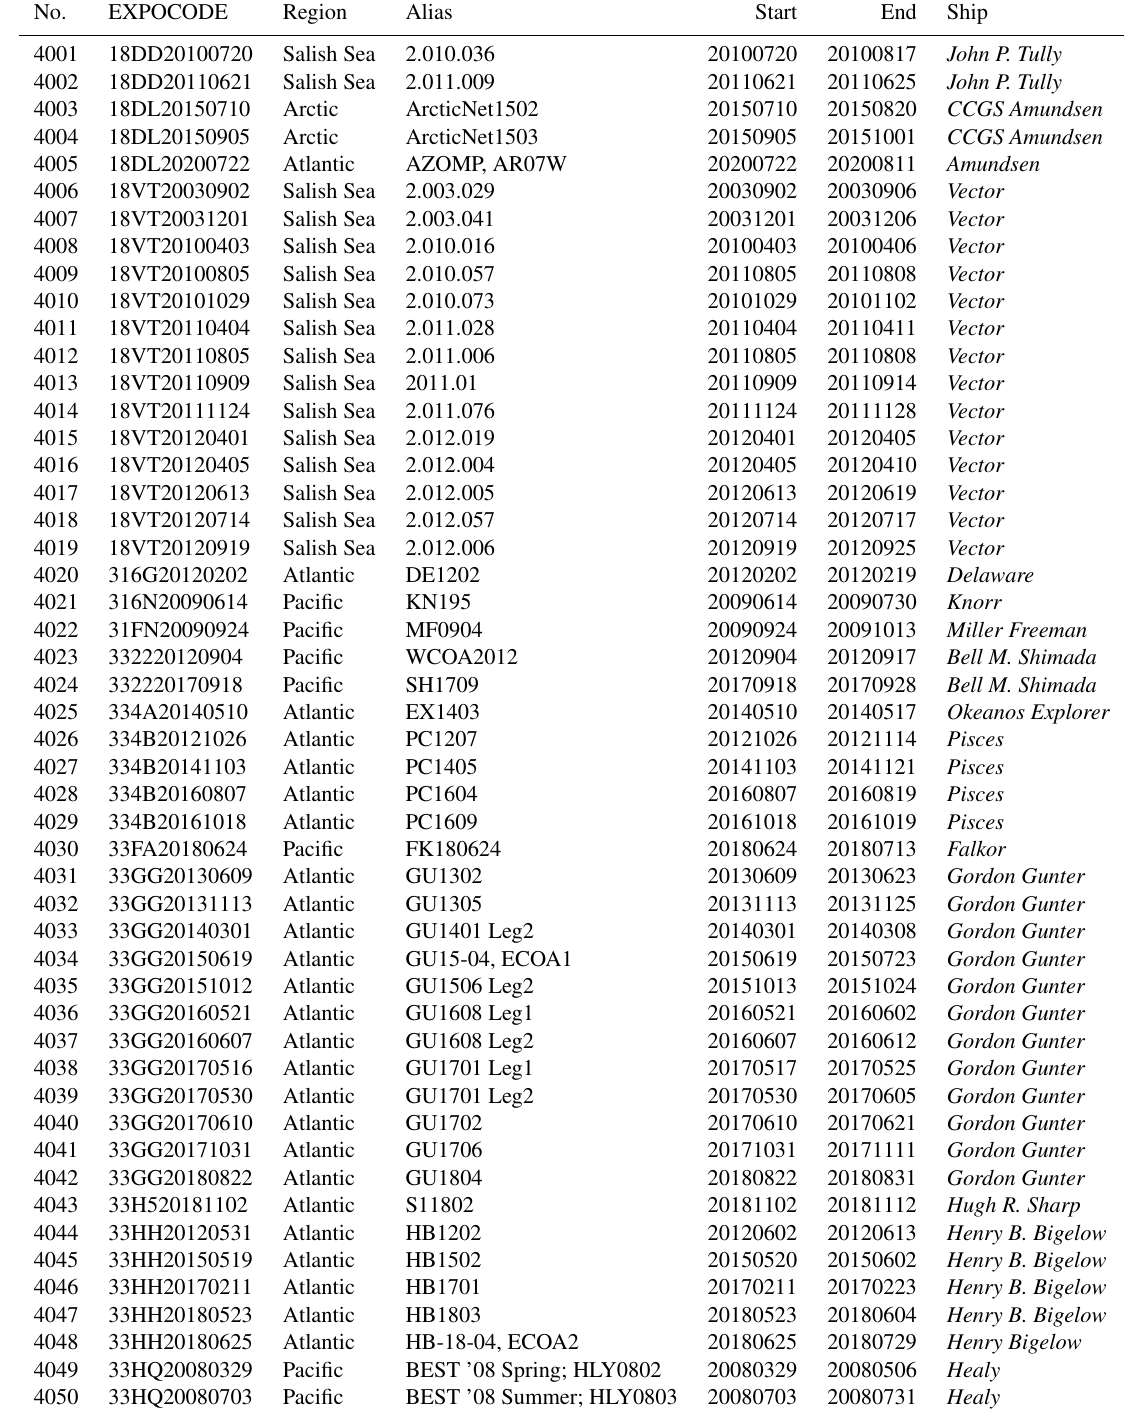
Table A1. Cruises included in GLODAPv2.2022 that did not appear in GLODAPv2.2021. Complete information on each cruise, such as variables included, and chief scientist and principal investigator names is provided in the cruise summary table at